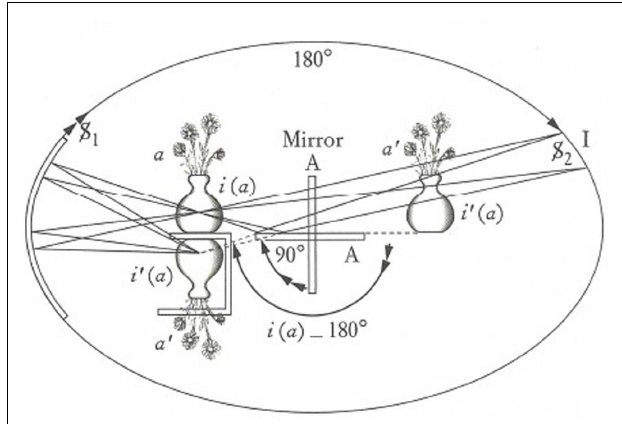
FIGURE 5 | Rotated mirror set-up. Reprinted from ECRITS by Jacques Lacan, translated by Bruce Fink. English translation copyright © 2006, 2002 byW.W. Norton & Company, Inc. Used with permission of the publisher,W. W. Norton & Company,